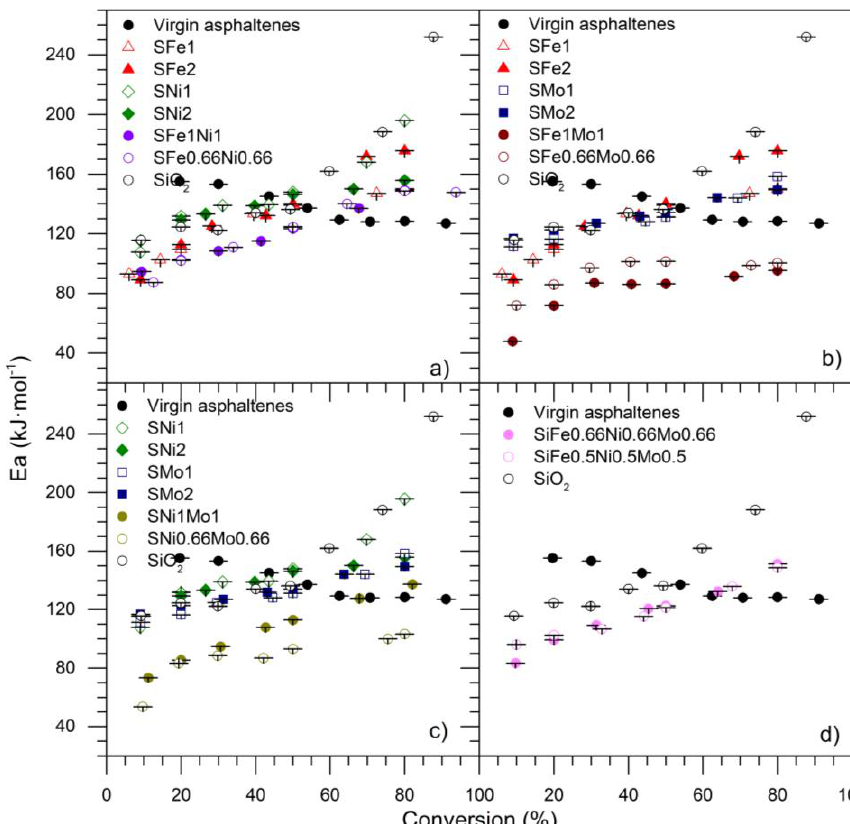
Figure 20. Activation energies obtained by the OFW method, evaluated for the oxidation of virgin asphaltenes and asphaltenes in the presence of SiO 2 and nanoparticles functionalized with transition elements. ( a ) The series Si-Fe-Ni, ( b ) Si-Fe-Mo, ( c ) Si-Ni-Mo, and ( d ) Si-Fe-Ni-Mo.